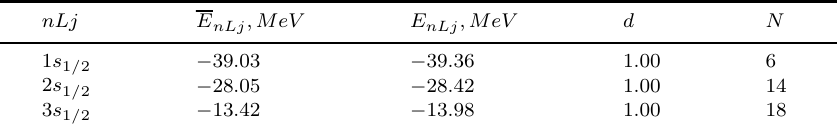
Table 1. The energy levels E nLj and E nLj of neutrons of nucleus 197 Au. nLj E nLj ,MeV E nLj ,MeV d N 1 s 1 / 2 − 39 . 03 − 39 . 36 1.00 6 2 s 1 / 2 − 28 . 05 − 28 . 42 1.00 14 3 s 1 / 2 − 13 . 42 − 13 . 98 1.00 18